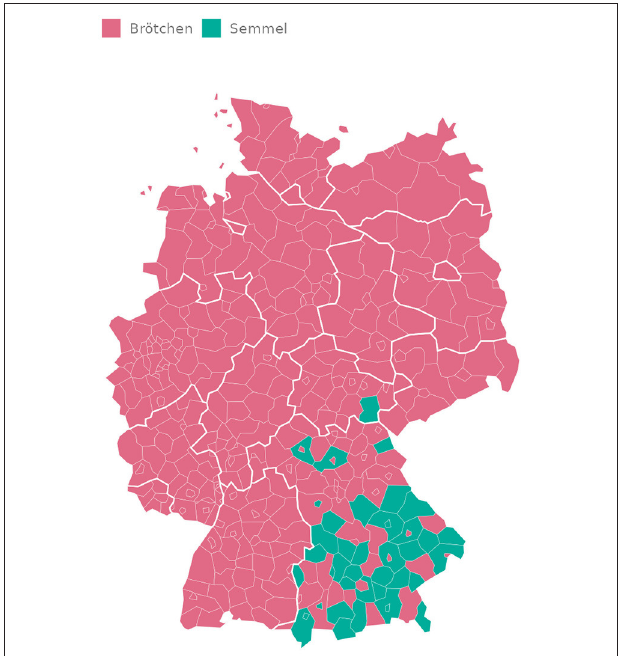
FIGURE 5 | Most common name for German bread rolls by NUTS-3